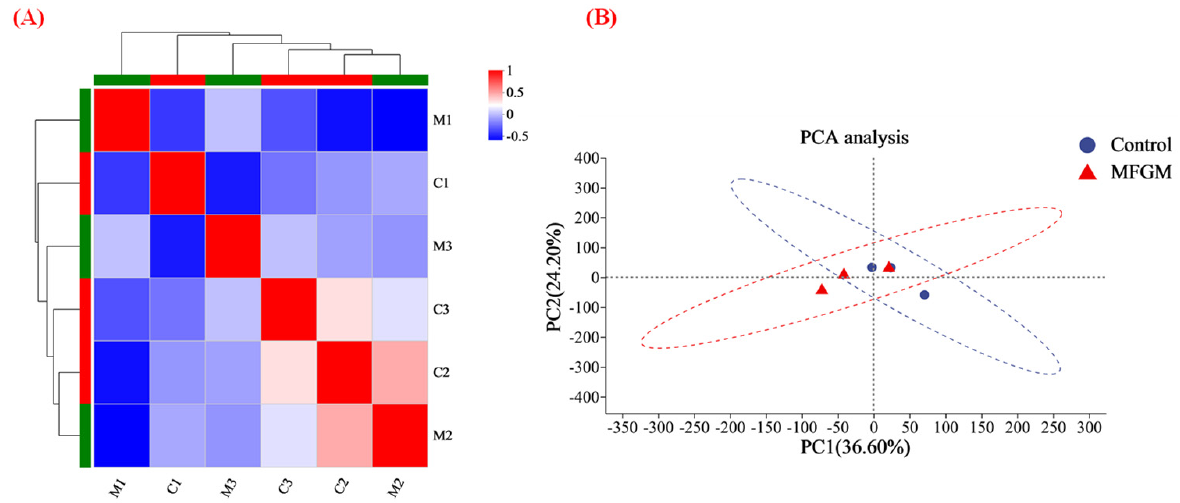
Figure 3. Functional annotation of whole proteins: ( A ) heat map of the correlation between M and C (C1, C2, C3 and M1, M2, M3 represent parallel samples of the control and experimental groups, respectively); and ( B ) PCA analysis. “MFGM” in ( B ) represent experimental groups.